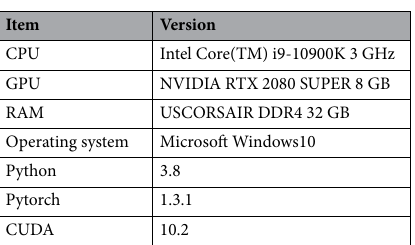
Figure 4. Diagrammatic overview of the proposed dataset. Legend: Trapezoid = camera; blue arrow = camera movement; red arrows = target movement.